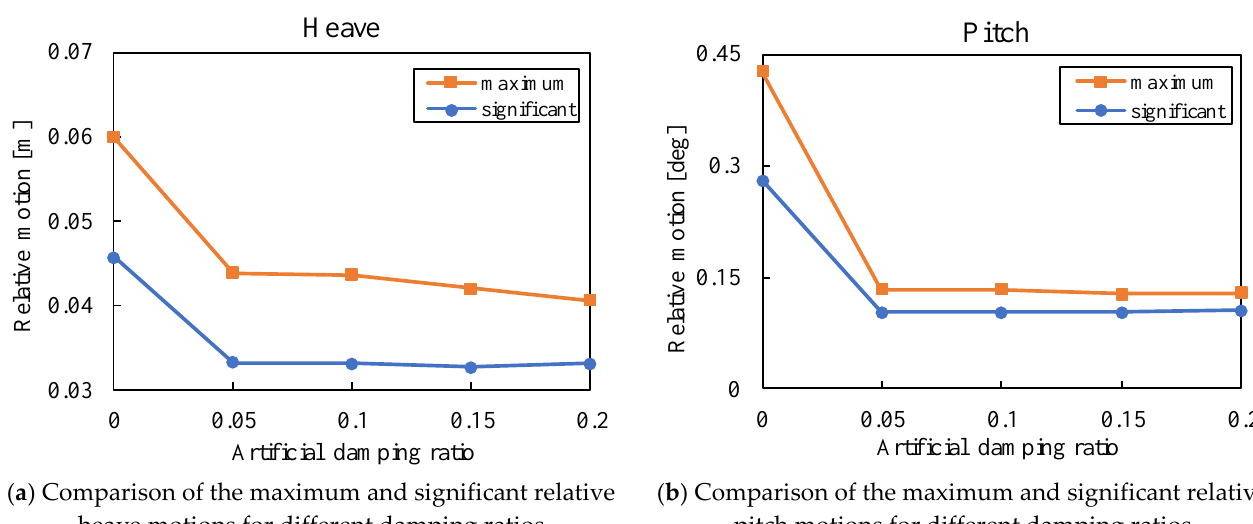
Figure 21. Time-domain responses under two irregular waves.